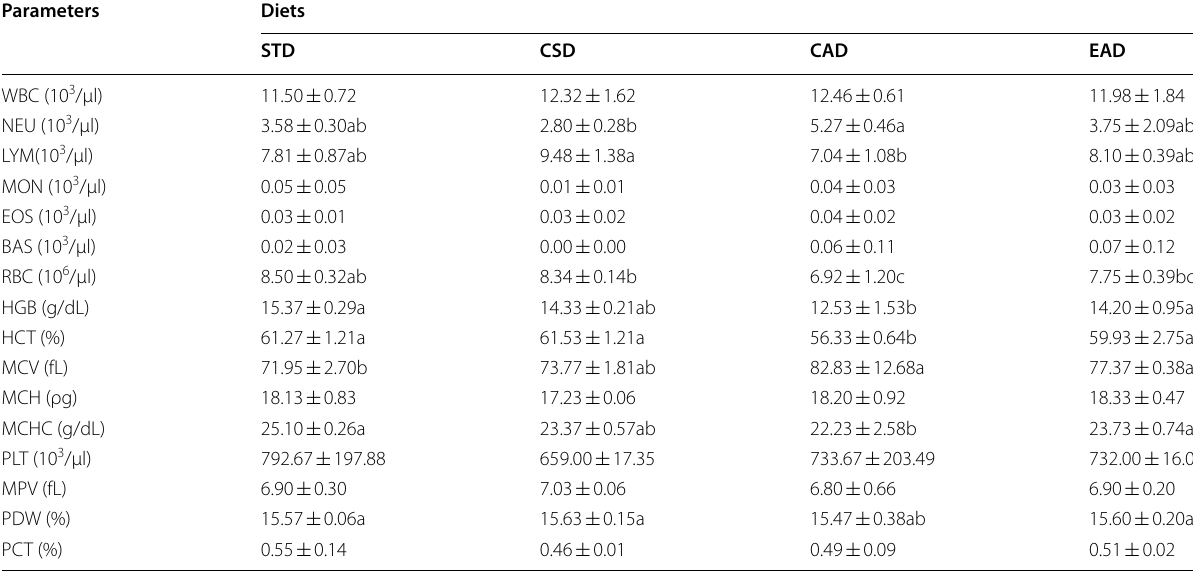
STD Standard diet, CSD Cottonseed diet, CAD standard diet with conventional aqueous extracted cottonseed milk for 1 ml/100 g of animal weight/day, EAD standard diet with enzyme assisted aqueous extracted cottonseed milk for 1 ml/100 g of animal weight/day; Values are mean animals; The values mentioned in superscripts are significantly different at P < 0.05 in the same row; WBC white blood cells, RBC red blood cells count, HGB hemoglobin, HCT hematocrit, PLT platelet, NEU neutrophils, LYM lymphocytes, MON monocyte, EOS eosinophil, BAS basophil, MCV mean corpuscular volume,